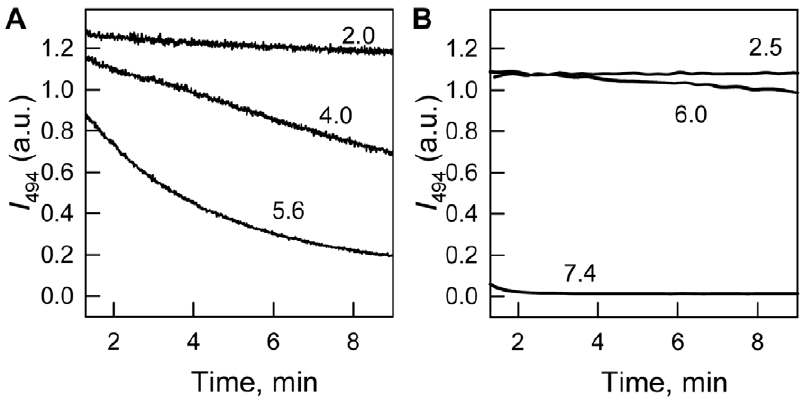
Figure 7. Kinetics of GdnHCl-induced unfolding of EGFP ( A ) and sfGFP ( B ). The changes of chromophore fluorescence intensity at 494 nm during first 10 min of protein unfolding are shown. l ex ~ 365 nm . Numbers at the curves indicate the denaturant